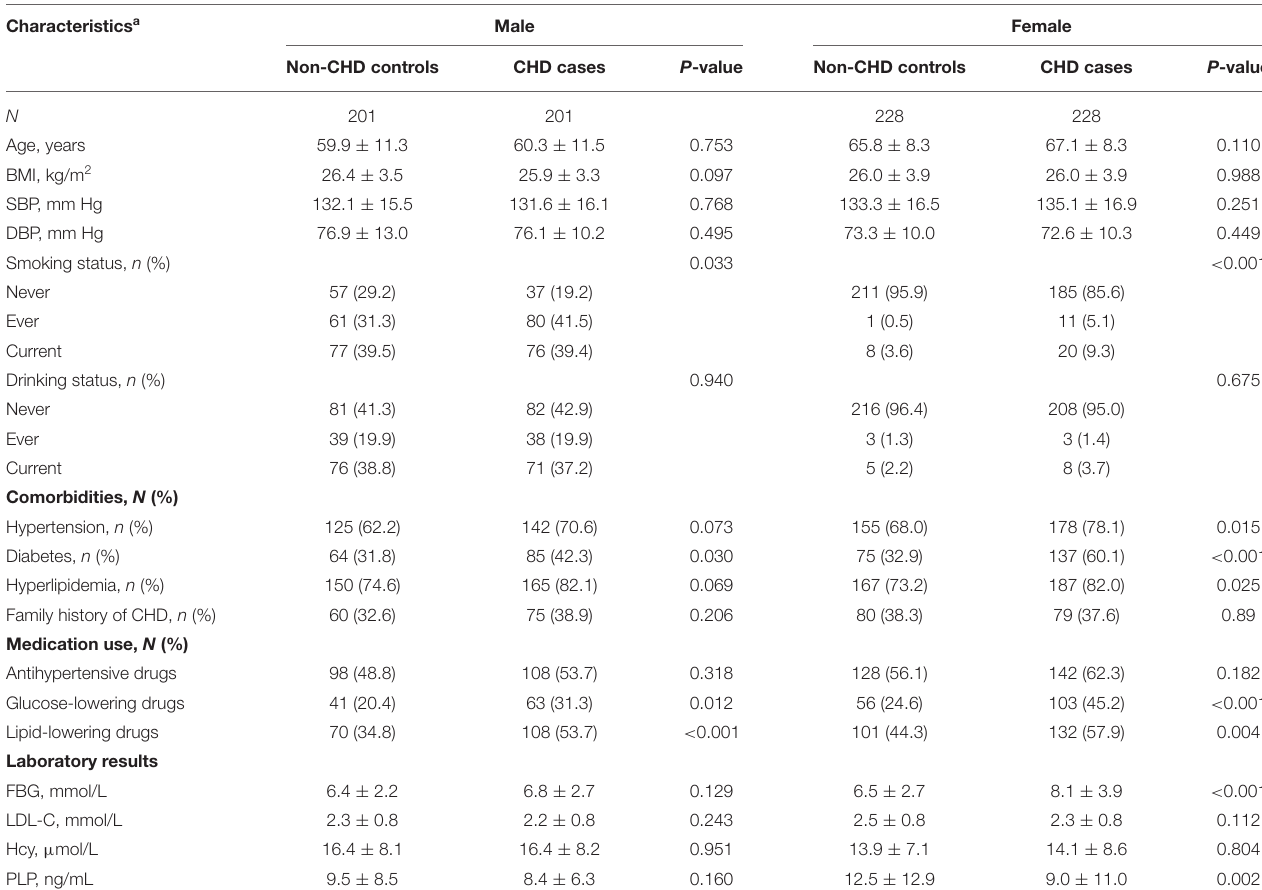
TABLE 1 | Characteristics of cases and control participants.